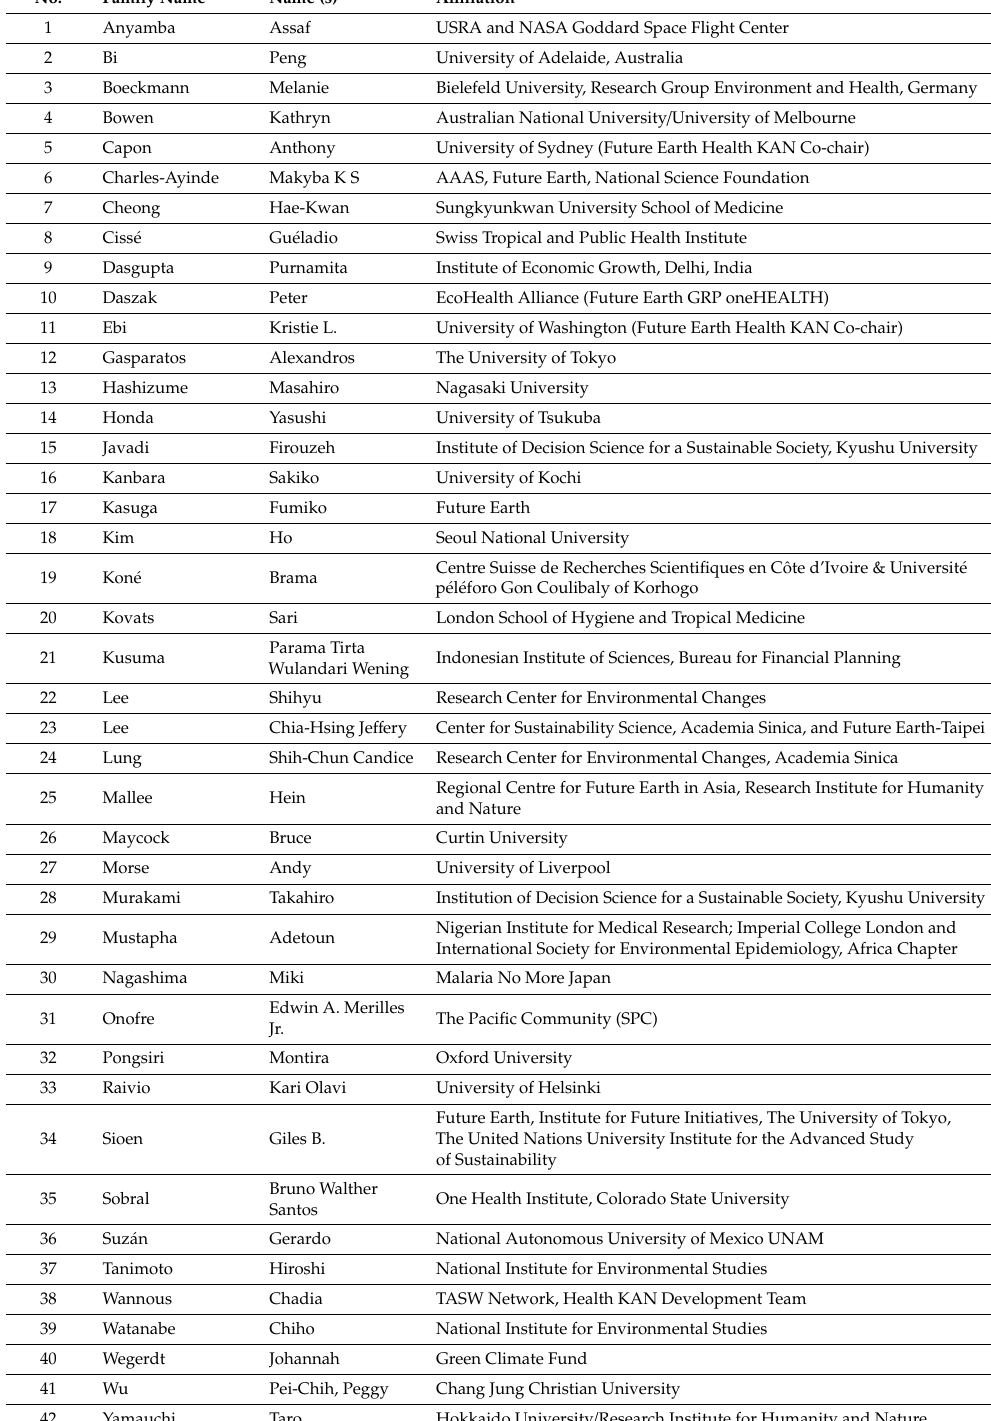
Table A1. Participants of the Health KAN launch